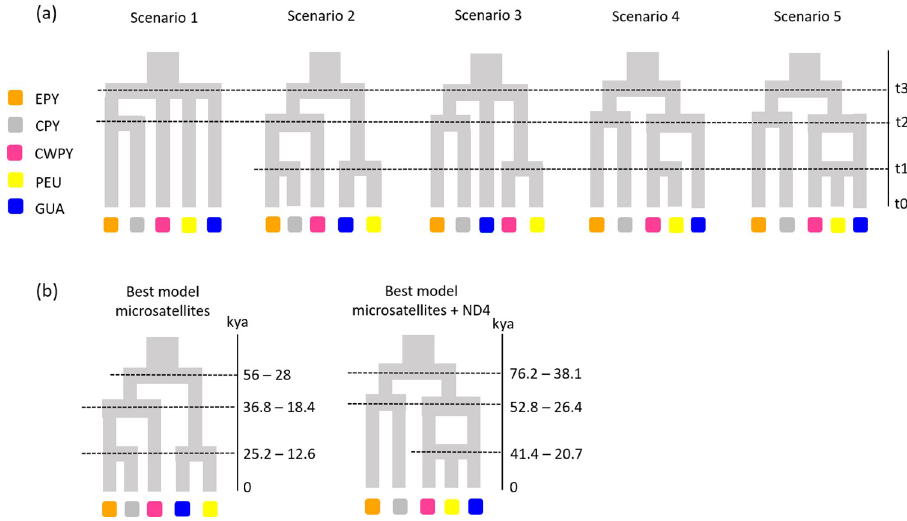
Fig 2. Phylogeographic scenarios tested in DIYABC and best supported models. (a) Scenarios tested in DIYABC considering the three analysed high mountain areas. (b) The best supported scenarios, namely number 2 when considering only microsatellites and number 5 when considering both mtDNA (ND4) and microsatellite markers, with the estimated divergence times (t1 –t3) of each split. Population groups were defined on the basis of their geographic distribution and the results from clustering analyses: eastern Pyrenees (EPY, orange), central Pyrenees (CPY, grey), central-western Pyrenees (CWPY, pink), Picos de Europa mountains (PEU, yellow), and Guadarrama Mountain Range (GUA,